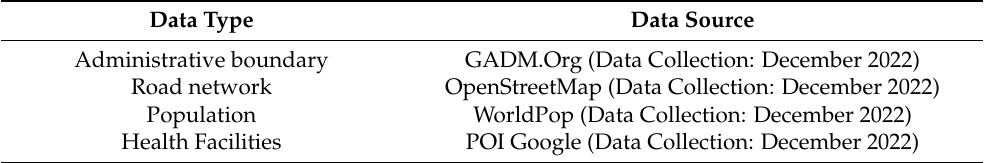
Table 1. Research